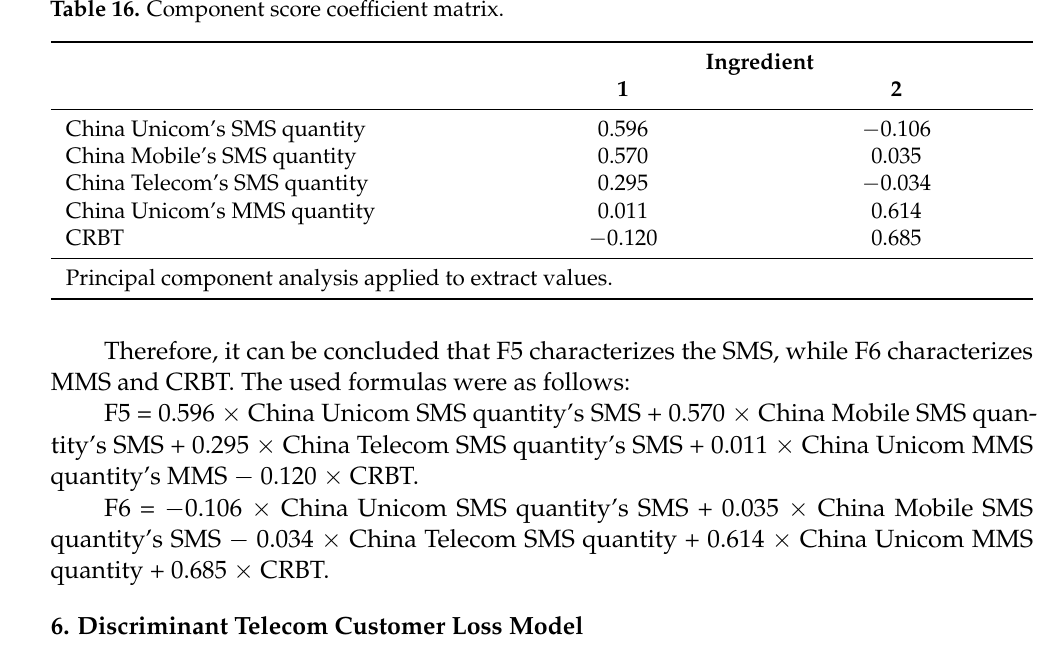
Table 16. Component score coefficient matrix.